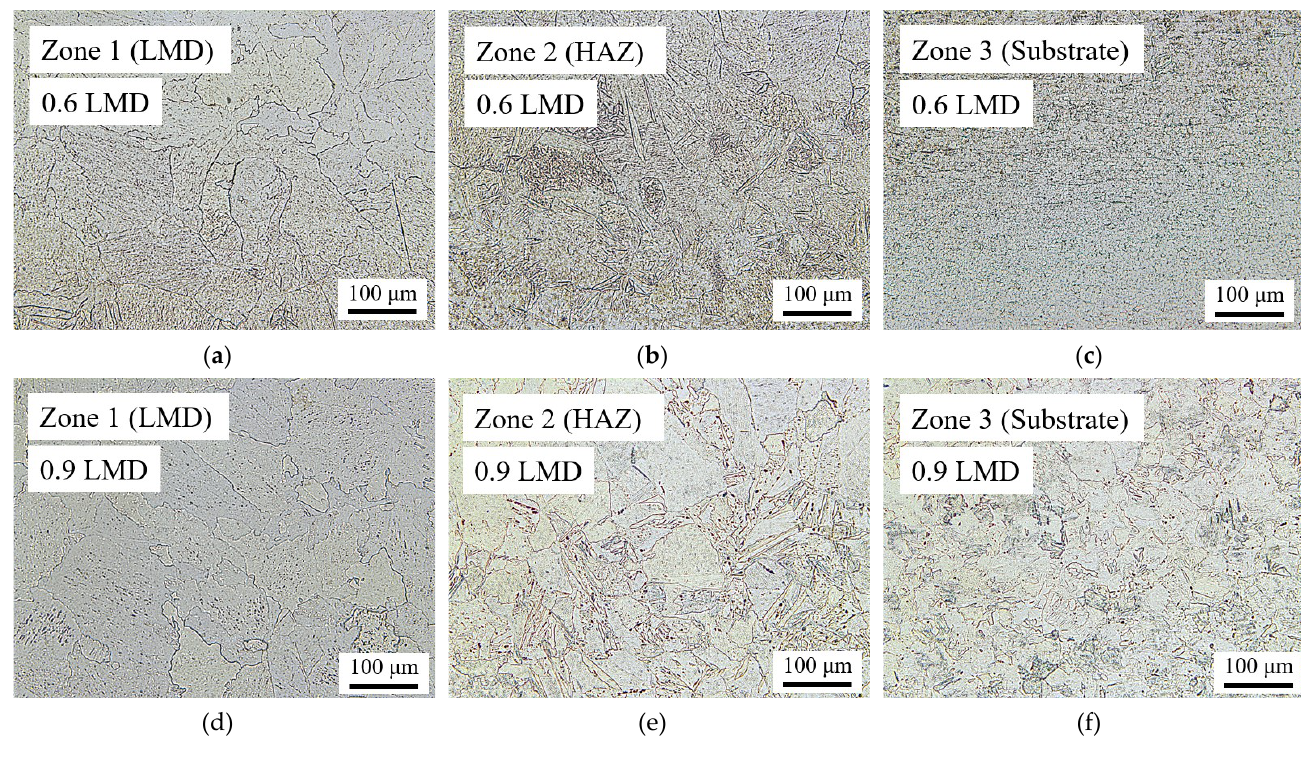
Figure 8. Optical images of 0.6 mm and 0.9 mm LMD samples across cross-section at ×20 magnification: ( a ) Zone 1 (LMD tailored material) of 0.6 mm LMD sample; ( b ) Zone 2 (Heat affected zone, HAZ) of 0.6 mm LMD sample; ( c ) Zone 3 (Non-transformed substrate) of 0.6 mm LMD sample; ( d ) Zone 1 (LMD tailored material) of 0.9 mm LMD sample; ( e ) Zone 2 (Heat affected zone, HAZ) of 0.9 mm LMD sample; ( f ) Zone 3 (Non-transformed substrate) of 0.9 mm LMD sample. The difficult sample preparation process for CP-Ti meant the microstructure was not clearly visible by optical microscopy. As such, EBSD analysis was performed on samples extracted from the LMD thickness to view its microstructure in greater detail. Grinding to depths of 0.3–0.6 mm below the material surface exposed the microstructure within Zone 1. Inverse pole figure (IPF) maps were generated, Figure 9. The RGB colour code: red for (0001), green for (1210) and blue for (0110) as shown in the standard stereographic triangle corresponds to the crystallographic orientation of each grain. The microstructure of the LMD part remains randomly orientated, Figure 9b,c, similar to the A-R microstructure, Figure 9a. Low magnification maps were used to measure the average grain size of the LMD tailored material using the intercept method. For the 0.3 mm thickened material, 158 grains were measured with an average grain size of 54.5 ± 0.2 μm and size range of 8.1 μm– 250 μm (SD = 56.9). For the 0.9 mm thickened material 158 grains were measured with an average grain size of 39 ± 0.2 μm and size range of 2.2 μm– 326.2 μm (SD = 57.7). The A-R material has an average grain size of 5.4 ± 0.2 μm (SD = 3.3). A grain growth of approximately x10 is observed in response to LMD. The higher SD of the LMD tailored microstructure suggests significant spread in grain size, in contrast to the lower SD of the A-R material which suggests a normal distribution of grain size. Twinning was observed in the LMD material. Some twins are seen to have nucleated and terminated on grain boundaries, labelled T1 in Figure 9d, whereas other twins nucleated on a boundary and terminated within the grain interior, labelled T2. Very small amounts of leftover transformed beta ( β ) phase is present in the LMD tailored material, likely a leftover during a phase transition in response to the LMD heating